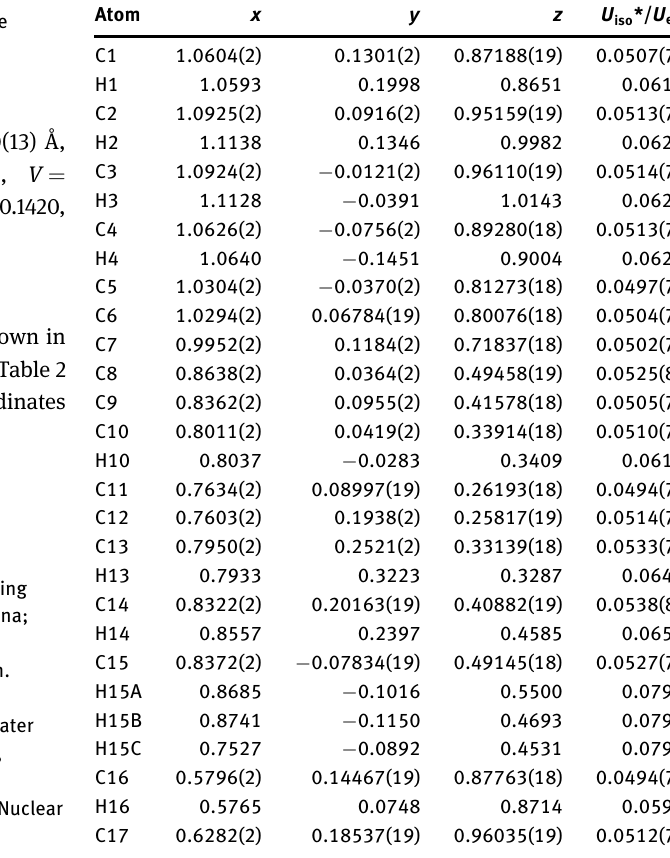
Table 2: Fractional atomic coordinates and isotropic or equivalent isotropic displacement parameters (Å 2